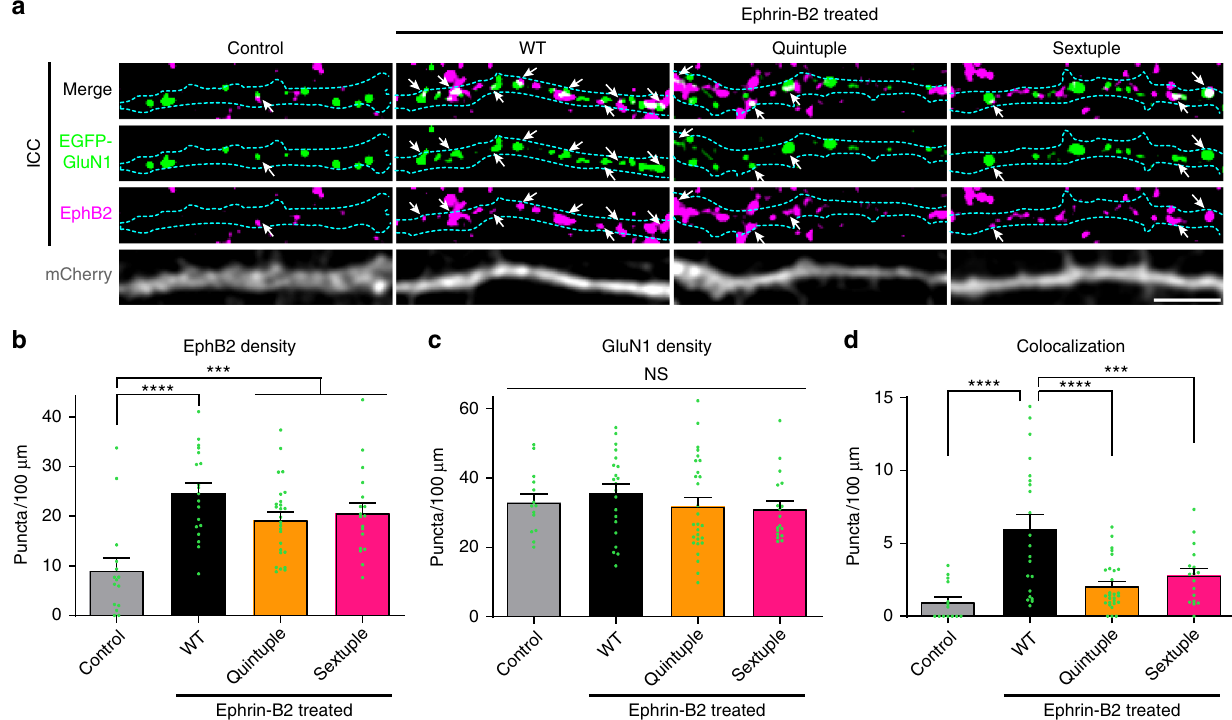
Fig. 3 GluN1 hinge mutants disrupt the EphB2 – GluN1 interaction in neurons. a Representative images of dendrites of DIV6-9 cortical neurons transfected with EGFP – GluN1 (WT, Quintuple, or Sextuple), mCherry, GluN2B, and CRISPR constructs to knock out endogenous GluN1. The control condition is WT GluN1-transfected treated with control reagents instead of ephrin-B2. The other three conditions were treated with ephrin-B2 for 45 min to induce the interaction between the NMDAR and EphBs. Top row panels show the colocalization between EGFP – GluN1 and EphB2 in white. Second row panels show the high contrasted images of EGFP – GluN1 puncta in green. Third row panels show the high contrasted images of endogenous EphB2 in magenta. Last row panels show mCherry. Outlines of morphology are shown in cyan. Scale bar = 5 µ m. b Quanti fi cation of EphB2 density (puncta number per 100 µ m) in indicated groups (*** p < 0.005, **** p < 0.0001, ANOVA followed by Tukey ’ s; green dots represent Control n = 14; WT n = 21 cells; Quintuple n = 28; Sextuple n = 18). c Quanti fi cation of EGFP – GluN1 density (puncta number per 100 µ m) in indicated groups ( p = 0.5958, ANOVA; green dots represent Control n = 14; WT n = 21 cells; Quintuple n = 28; Sextuple n = 18). d Quanti fi cation of the effects of the different GluN1 mutants on colocalization